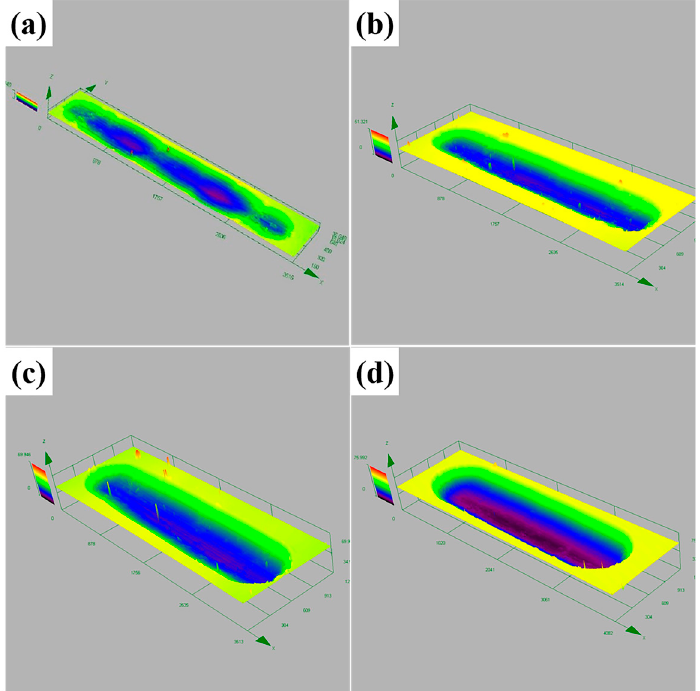
Figure 10. 3D-profile of the wear tracks for USRP treated samples (1000 N 6 passes) under different sliding time: ( a ) 3; ( b ) 6; ( c ) 9 and ( d ) 15 min. sliding time: ( a ) 3; ( b ) 6; ( c ) 9 and ( d ) 15